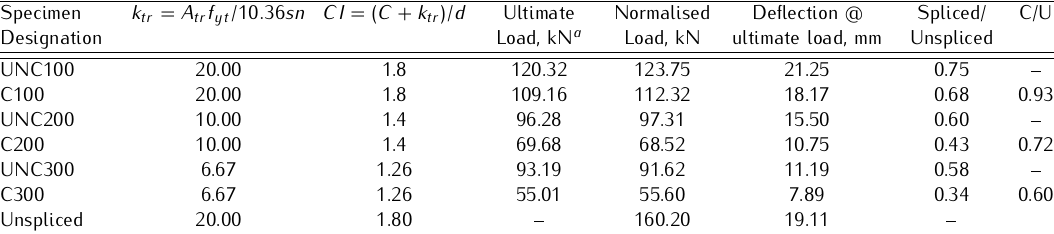
Table 3. Beam test results